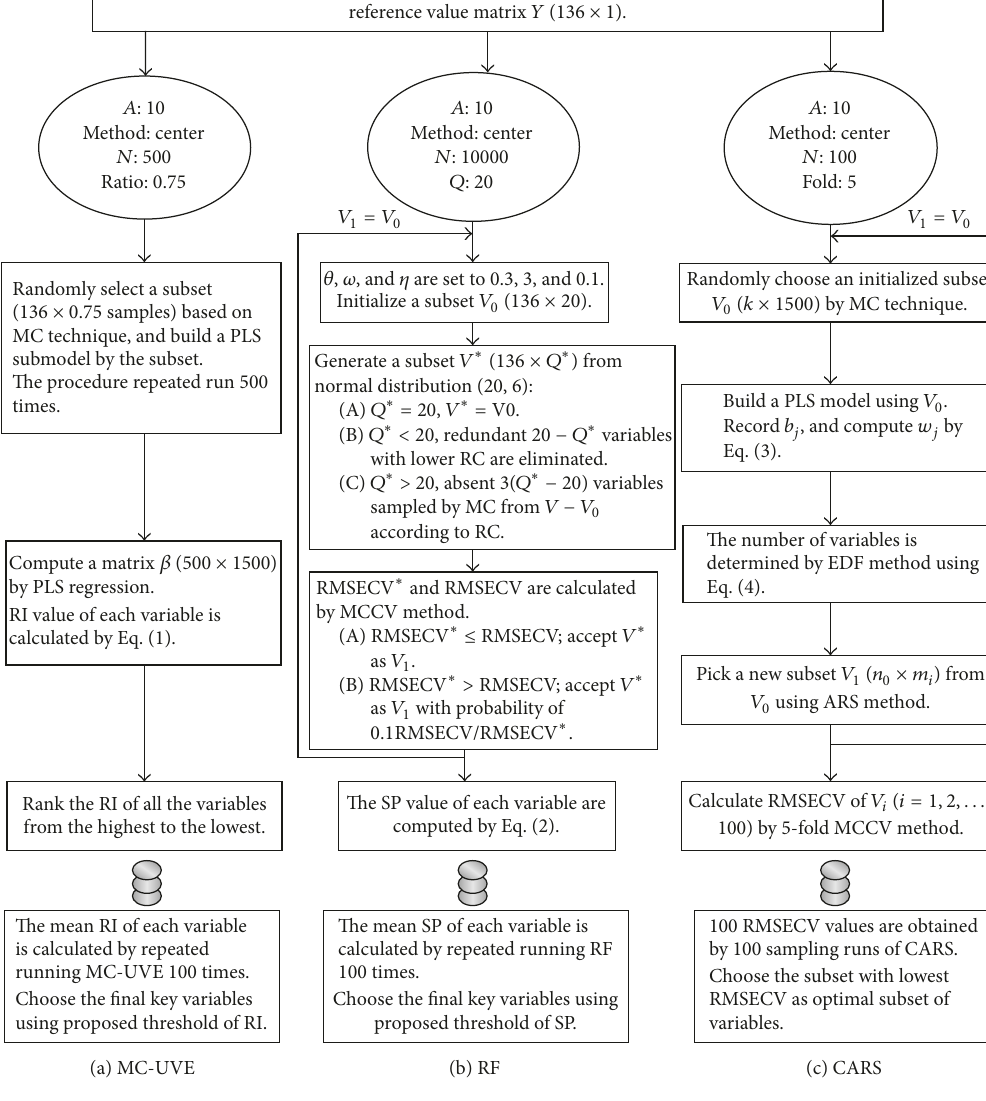
Figure 1: Flowchart of the MC-UVE, RF, and CARS